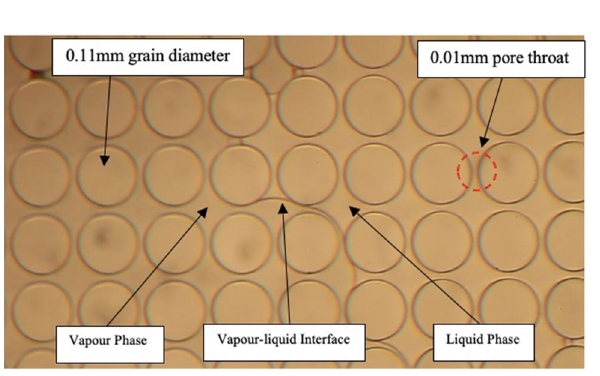
Figure 5. Propane vaporization in the homogenous micromodel (0.11 mm grain diameter and 0.01 mm pore throat).